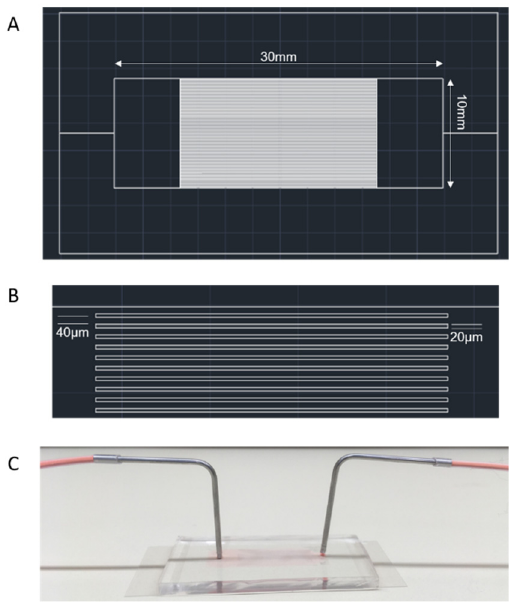
Figure 1. ( A ) Overall mask design for the PDMS channels. ( B ) Magnified mask design showing the dimensions of the channels. ( C ) PDMS channel.